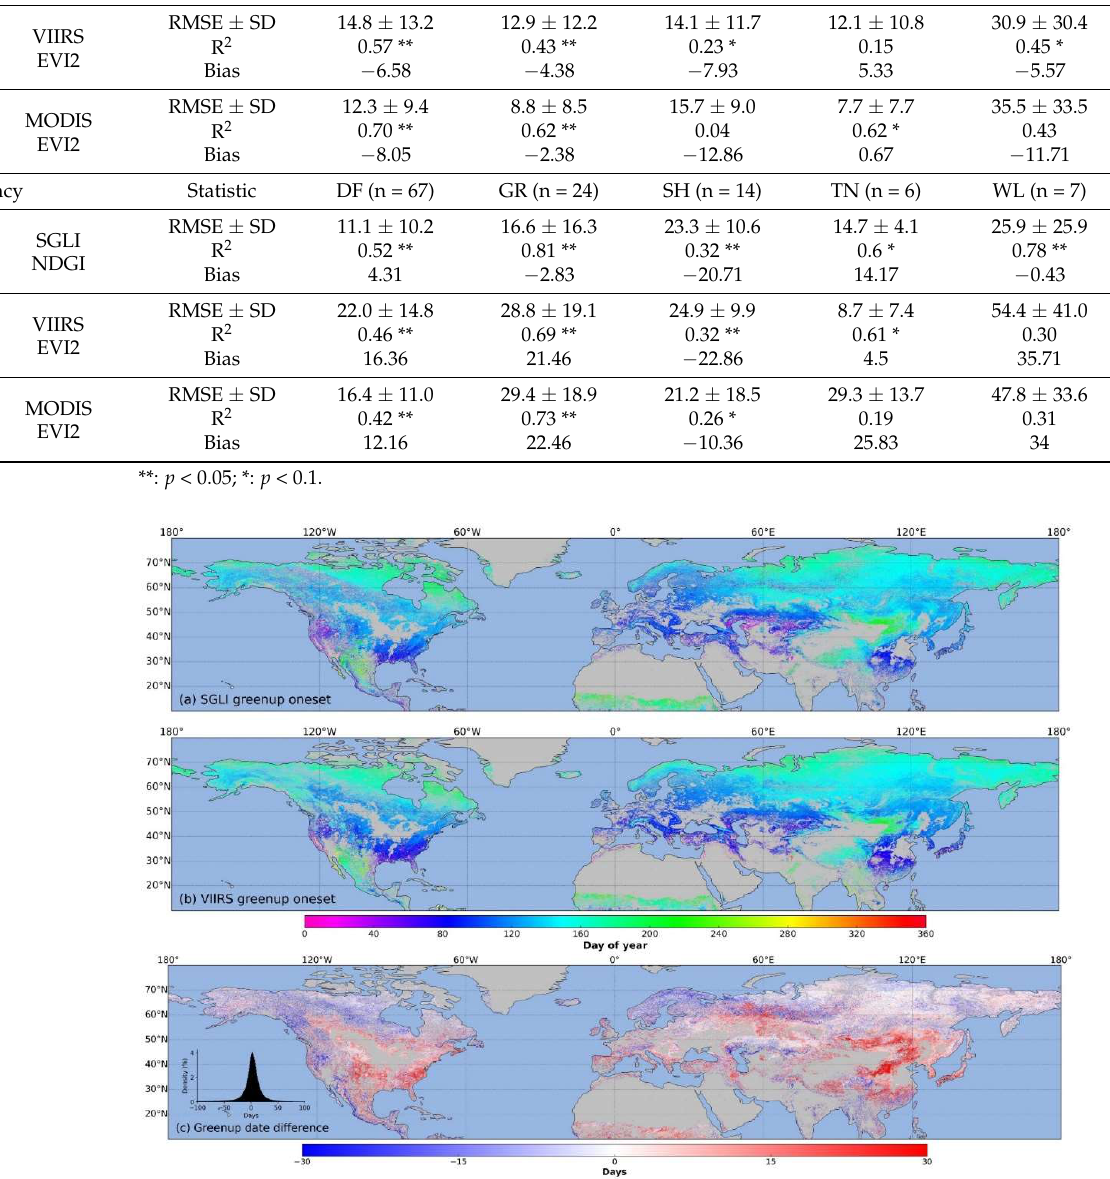
Figure 5. Spatial distribution of green-up dates retrieved from SGLI ( a ) and VIIRS ( b ) and relative differences ( c ) in the northern hemisphere in 2018. Positive (negative) differences mean SGLI dates are later (earlier) than VIIRS dates.